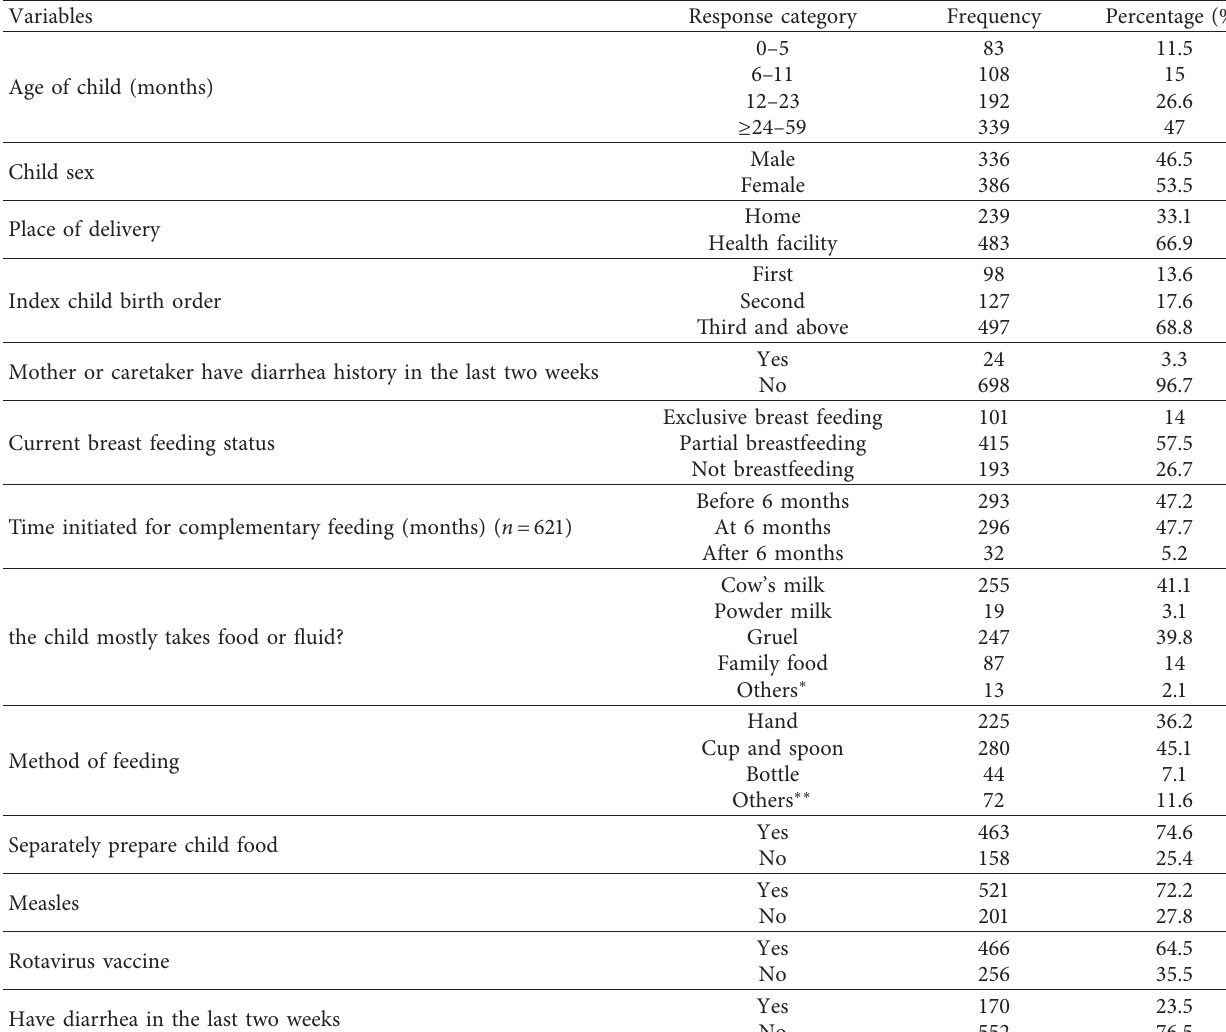
Table 3: Demographic and health characteristics of the indexed children in Benna Tsemay District, South Omo Zone, Southern Ethiopia, 01 January to 30 February,